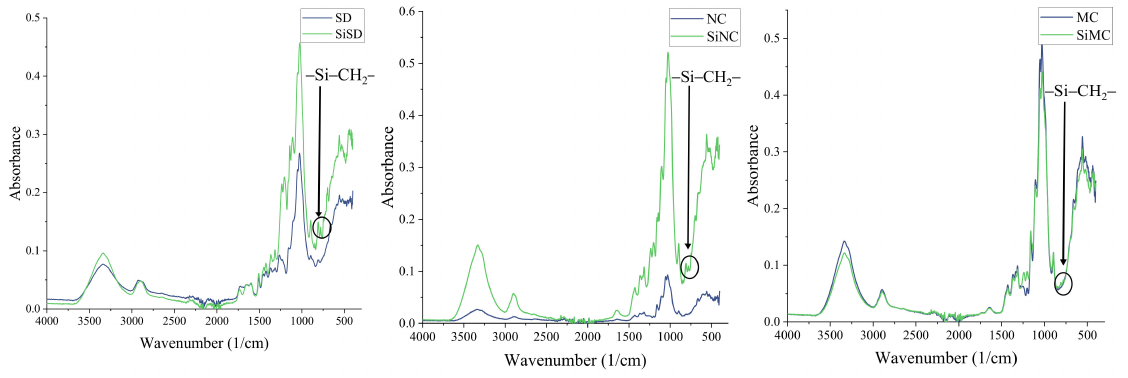
Figure 8. FTIR spectra of SD and SiSD ( left ), NC and SiNC ( middle ), and MC and SiMC ( right ).